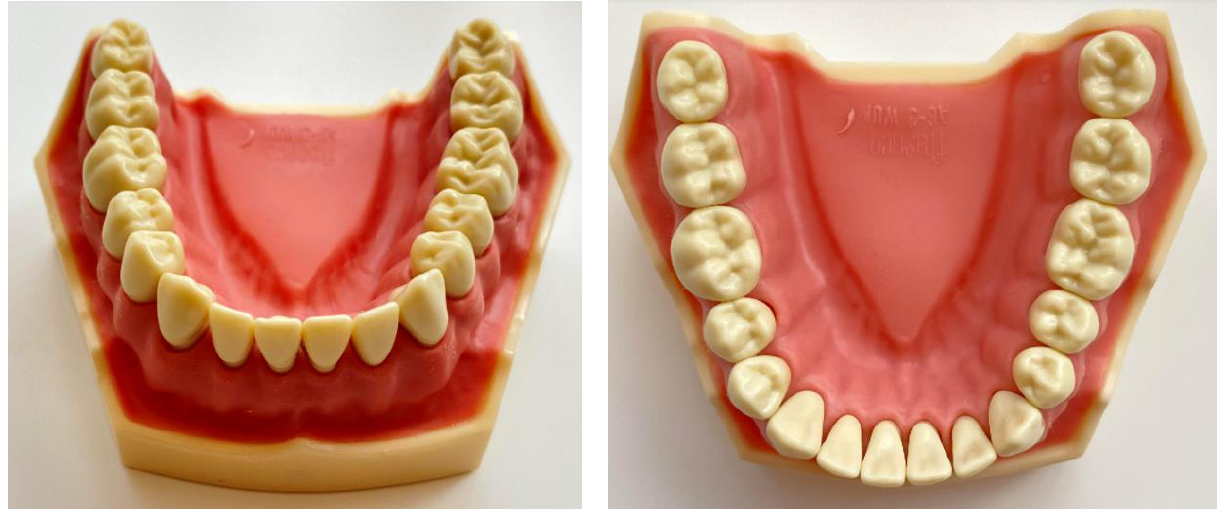
Figure 1. Model used for the reference comparison.